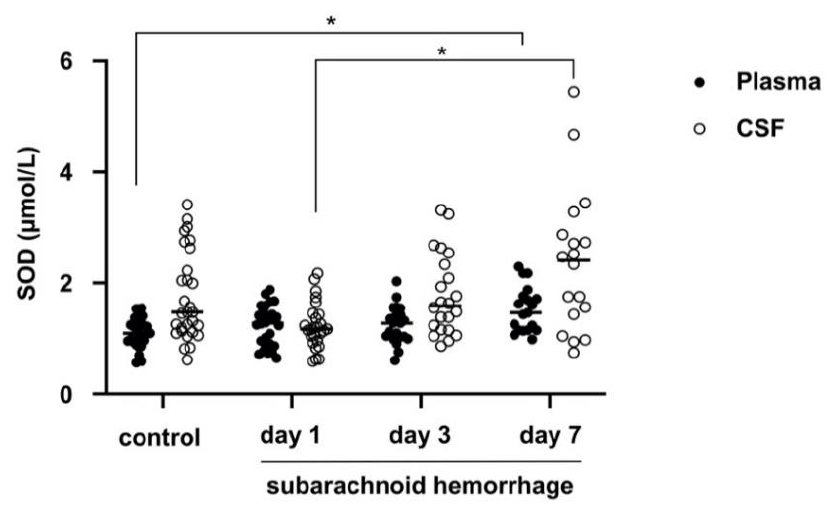
Figure 1. Superoxide dismutase (SOD) in plasma and cerebrospinal fluid (CSF) from patients with subarachnoid hemorrhage (SAH) and controls: Plasma and CSF levels of SOD increased from day 1 to 7 after SAH. *: p < 0.05.